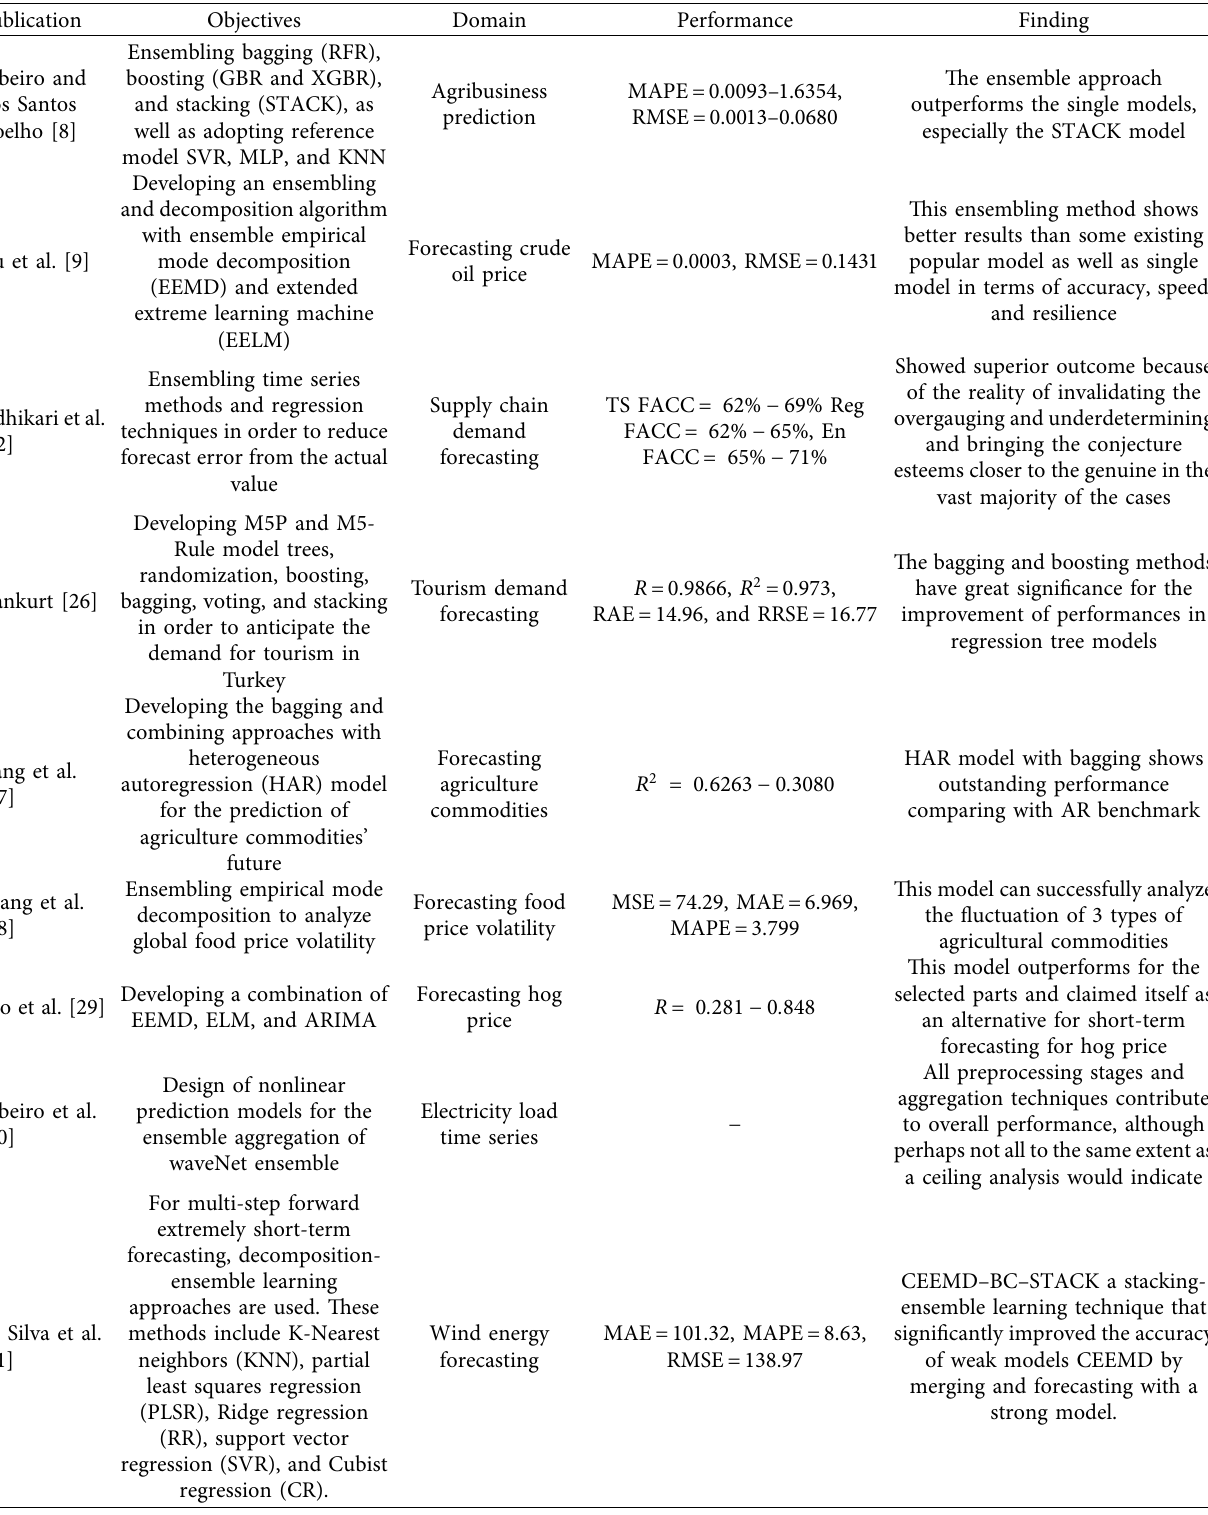
Table 1: Summary of most recent works for demand forecasting in various fields with their input factors and